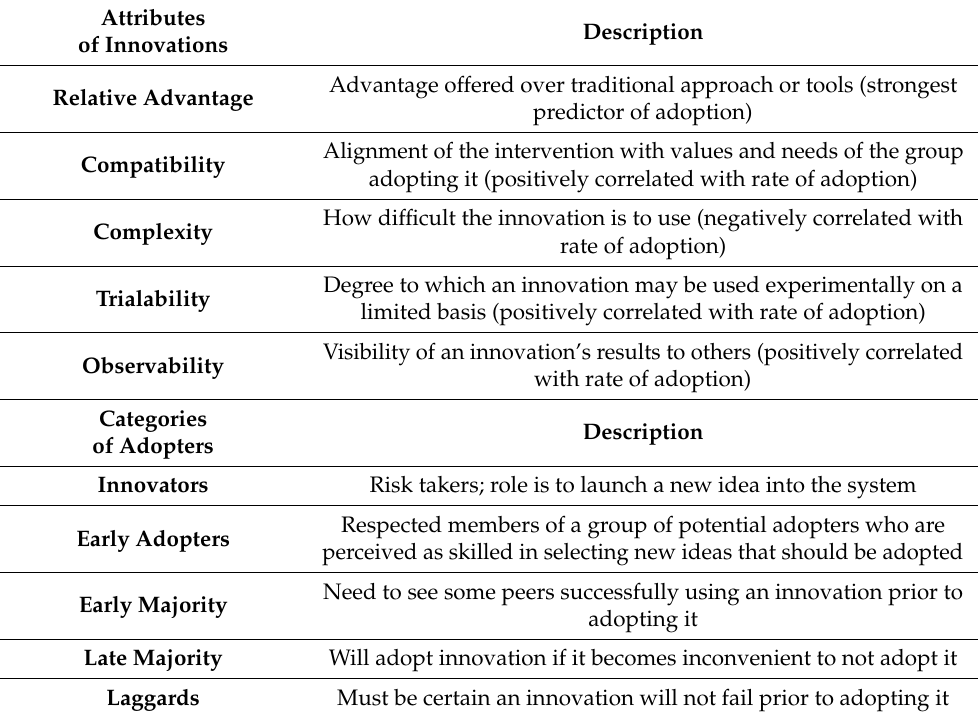
Table 1. Diffusion of Innovations Theory